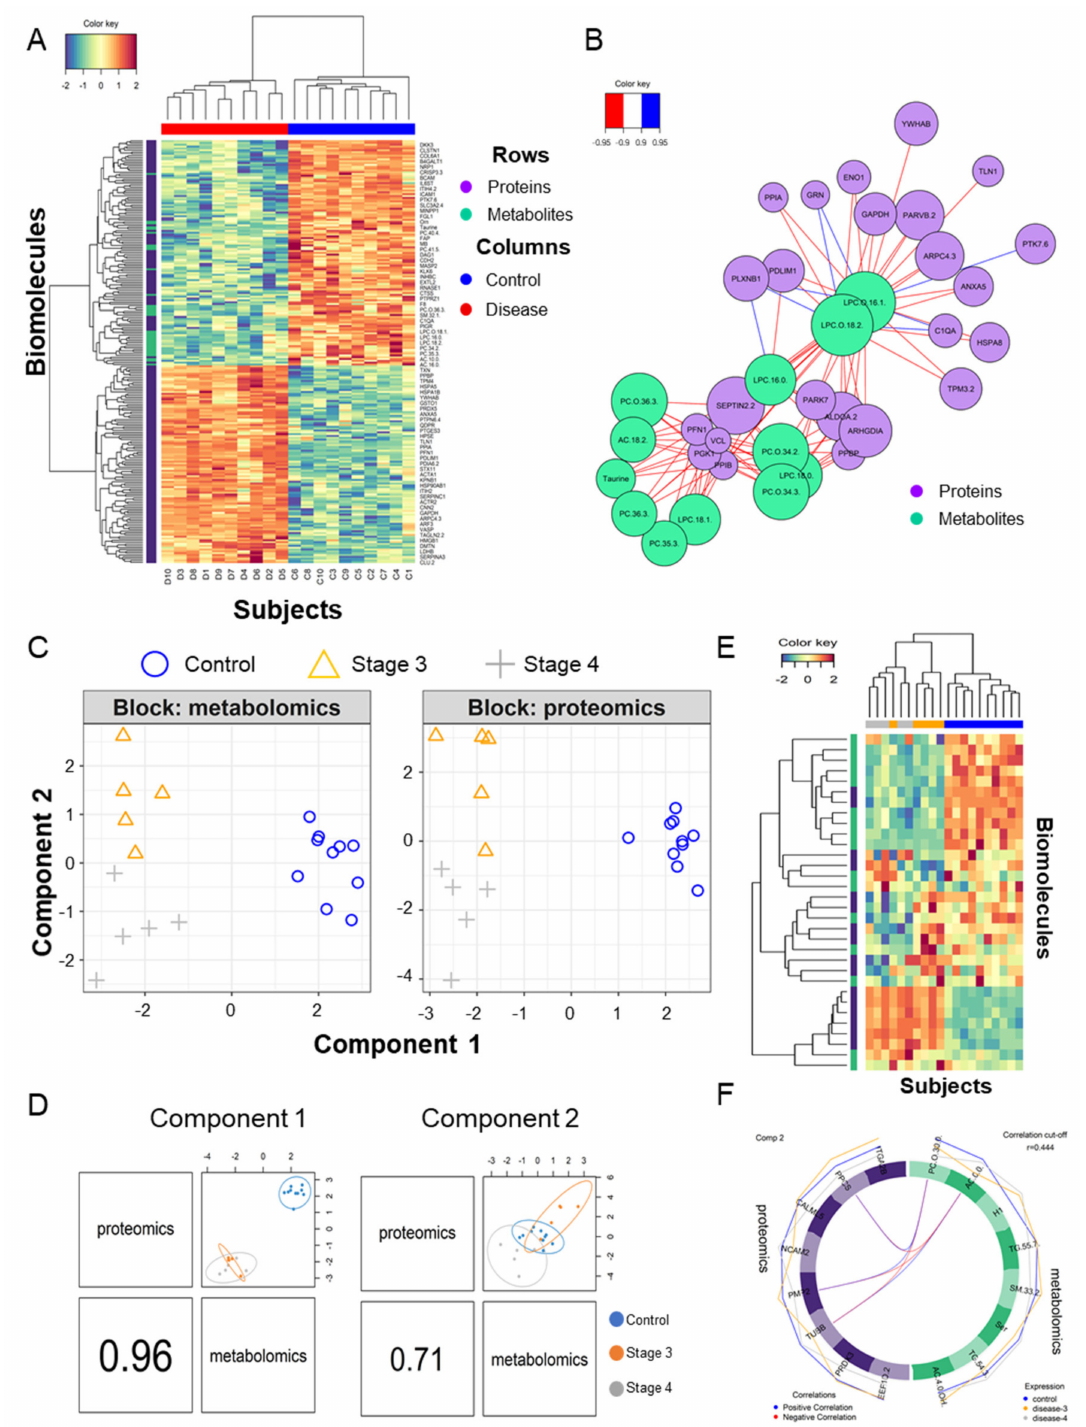
Figure 4. Multiomics combined analysis of metabolome and proteome. ( A ) Heatmap of hieratical clustering of 34 DAMs and 197 DAPs in the two groups (control and disease); ( B ) Diagram of the correlation between DAMs and DAPs with a correlation between them with an absolute value of 0.9 or higher. ( C ) Blocked sparse PLA-DS analysis of metabolites and proteins that divide the control, stage 3, and stage 4 groups; ( D ) Scatter plot of the 1st component of the proteome and metabolome in the three groups; the second component also appears the same. ( E ) Heatmap of hieratical clustering of eight metabolites and proteins contributing to components 1 and 2, respectively; ( F ) Diagram of the correlation between eight metabolites and eight proteins contributing to component 2 with a correlation between them with an absolute value of 0.444 or